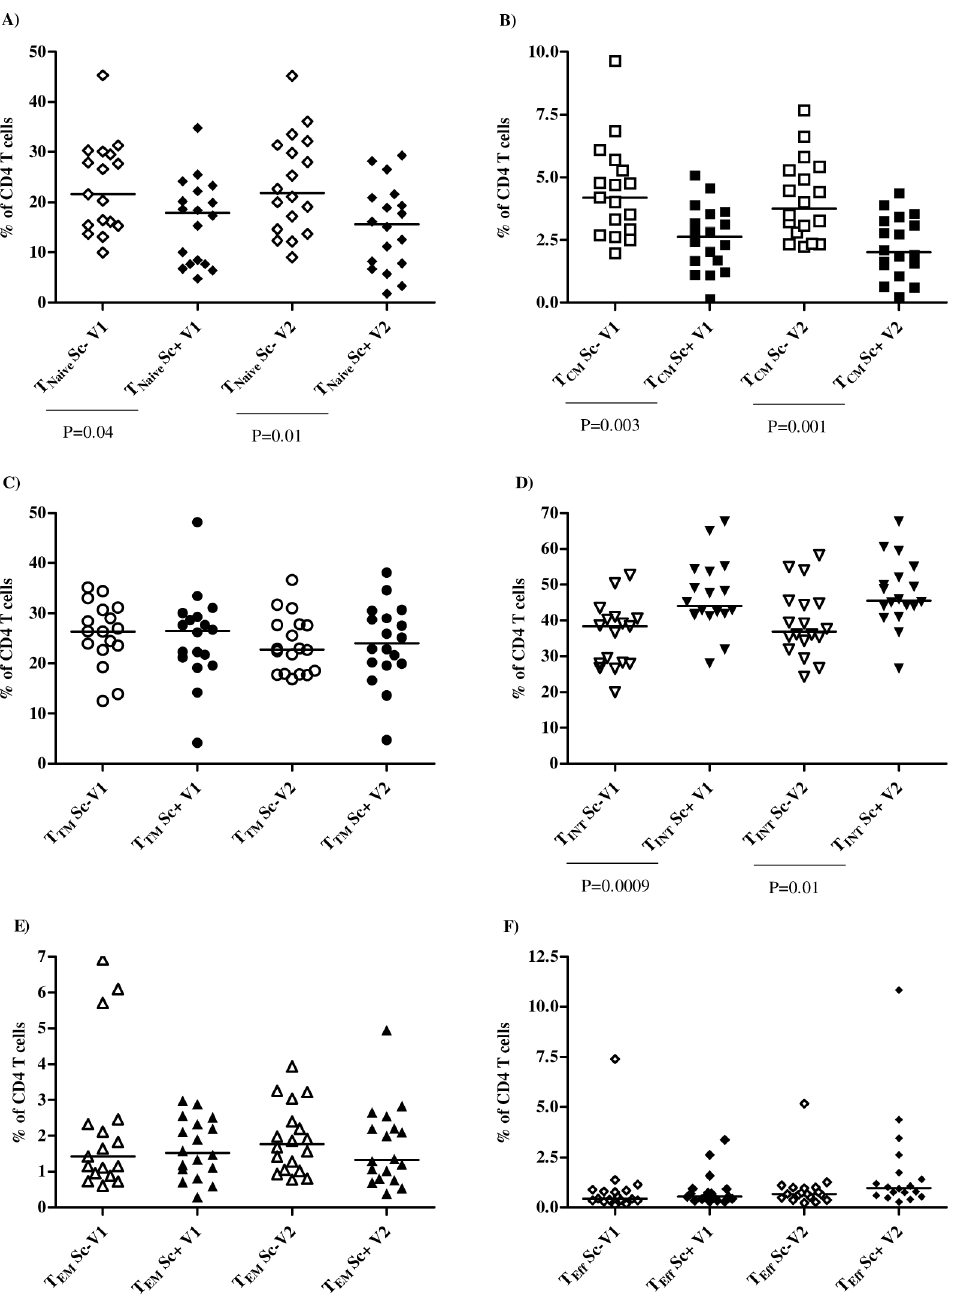
Fig. 2. Predominance of CD4 + T INT memory subset among HIV + seroconverters. Frequency and median (lines) of CD4 + T Naive (A), T CM (B), T TM (C), T INT (D), T EM (E) and T Eff (F) subpopulations in seroconverters (Sc + , closed symbols) and non-seroconverters (Sc-, open symbols) before (V1) and after (V2) vaccination.